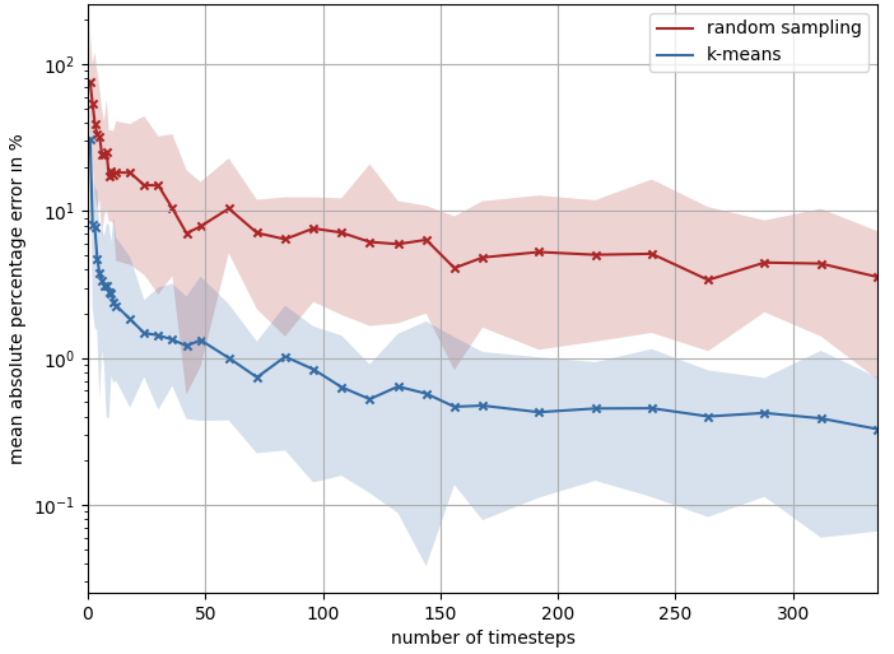
Figure 8. Comparison of the accuracy in time series aggregation using k-Means and random sam- pling.